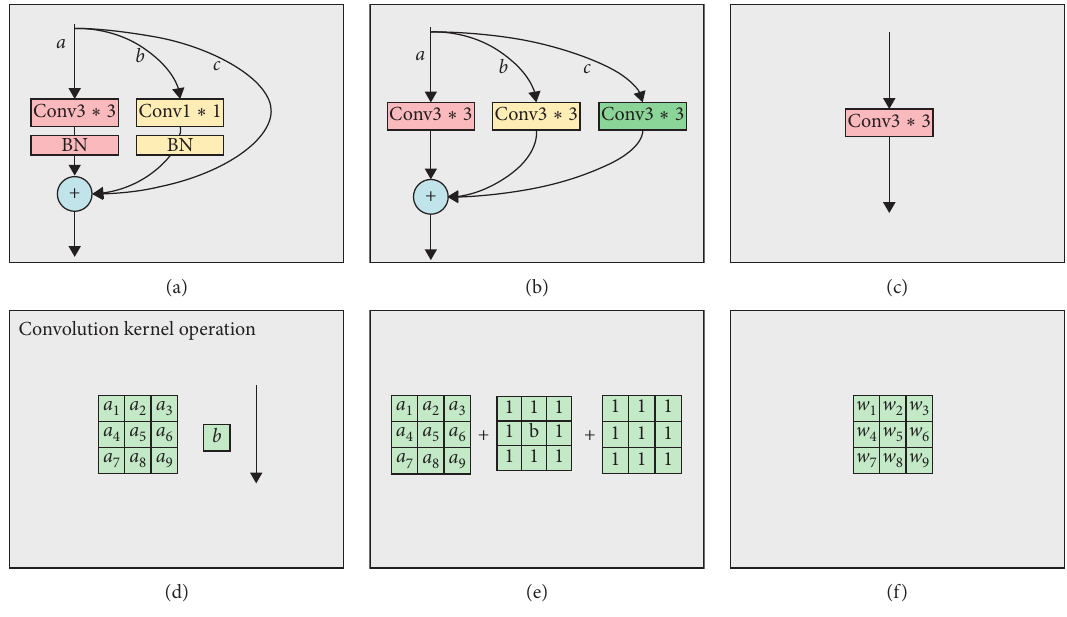
Figure 3: Structure reparameterization process of RepUnit component.